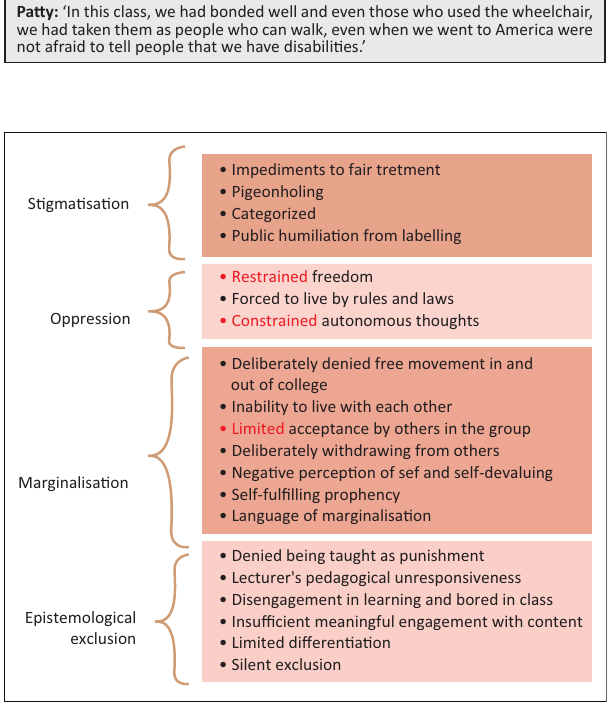
FIGURE 2 : Exclusion and the